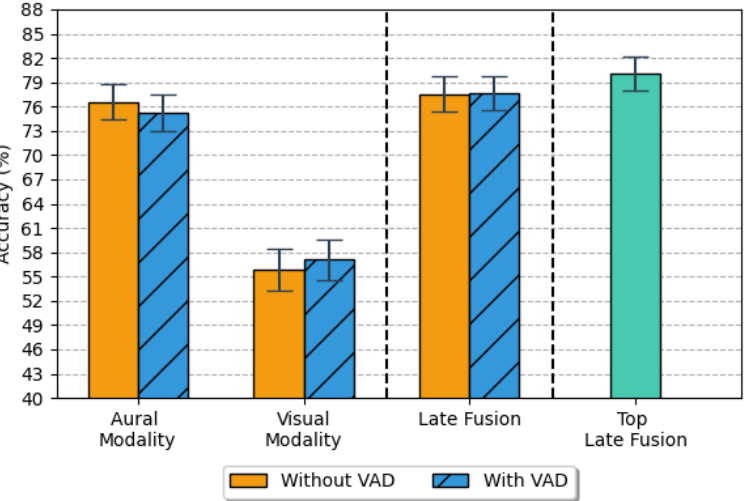
Figure 7. The top average accuracy of the 5-CV obtained for speech and visual modalities with a 95% confidence interval. In orange, the experiments with the original videos; in blue, the samples with speech; in green, the mix of the top modalities: the speech model without VAD and the visual model with